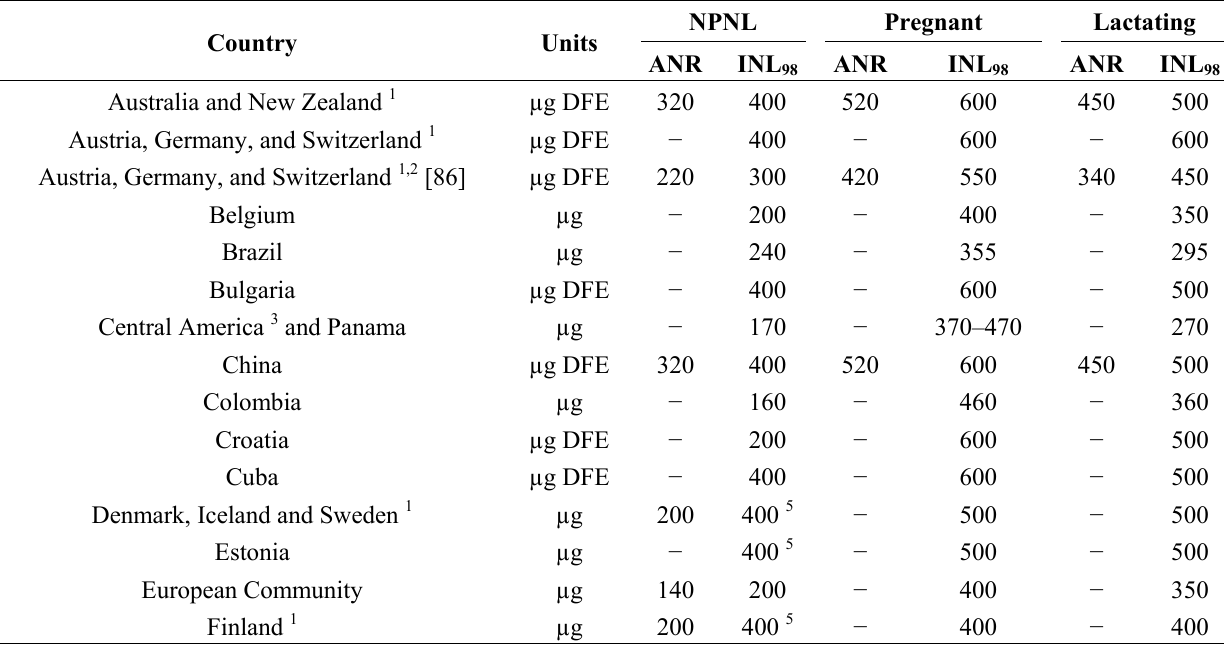
Table 2. Nutrient intake values for non-pregnant, non-lactating (NPNL), pregnant, and lactating women by